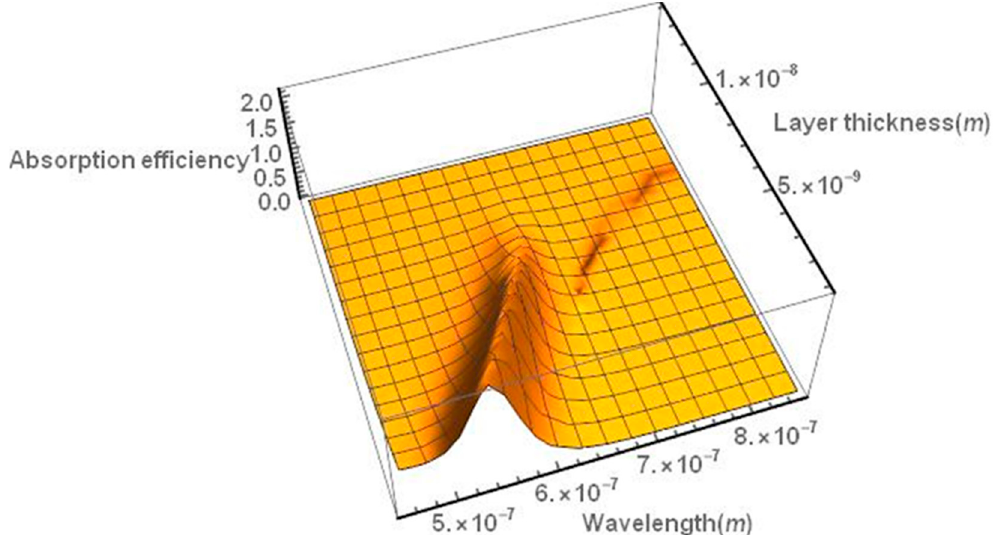
Figure 4. Absorption efficiency spectrum of a gold nanoparticle covered with a TiO 2 layer as a function of the thickness of the titanium layer. The spectrum is red-shifted as the thickness of the dielectric layer increases. The particle diameter is assumed to be 30 nm.